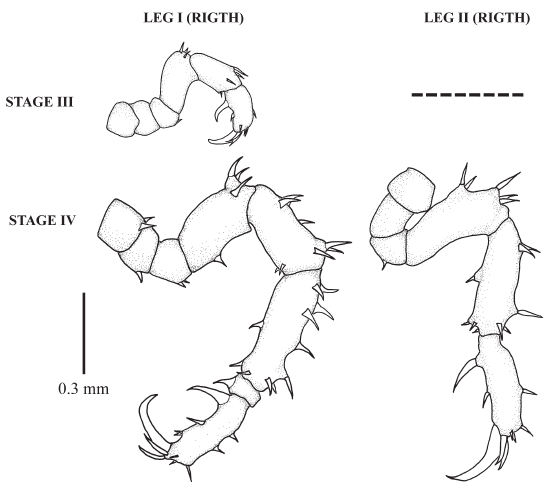
Fig . 3. – larvae of Ammothea glacialis (Hodgson, 1907). Walking legs of the third and fourth instar